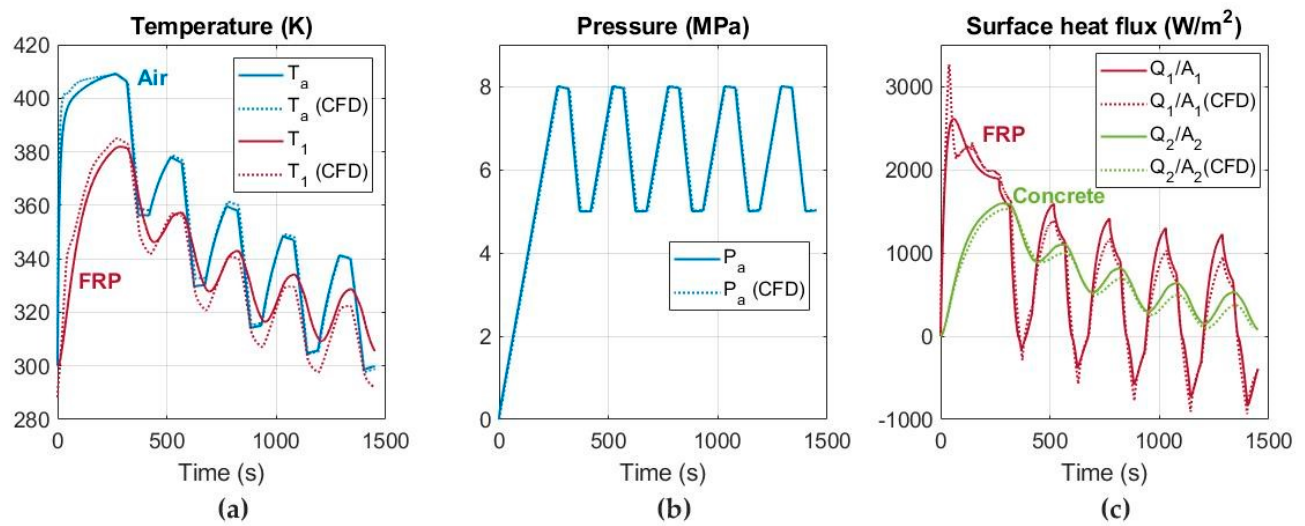
Figure 14. Comparative analysis between analytical and numerical models for 5 charging and discharging cycles considering FRP as sealing layer. ( a ) Temperature of air and FRP; ( b ) Air pressure; ( c ) Surface heat flux of FRP and concrete lining.